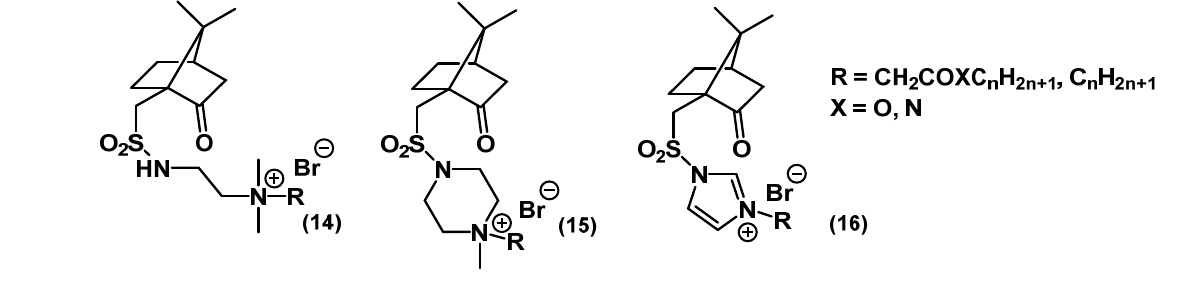
Figure 9. CSA-based mono-QACs.